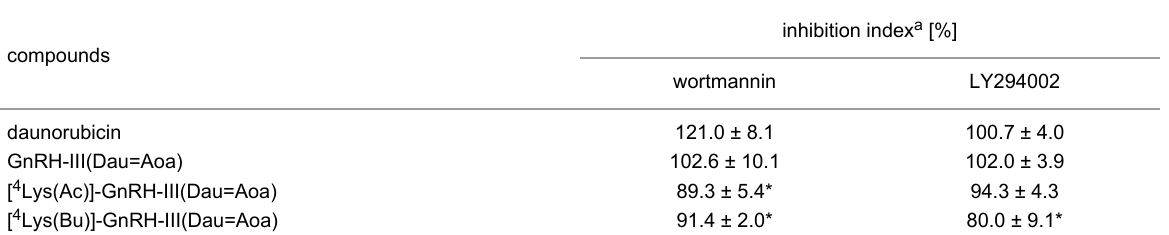
Table 3: The effect of the inhibition of phosphatidylinositol 3-kinase on the antitumor activity of conjugates and daunorubicin (Dau).